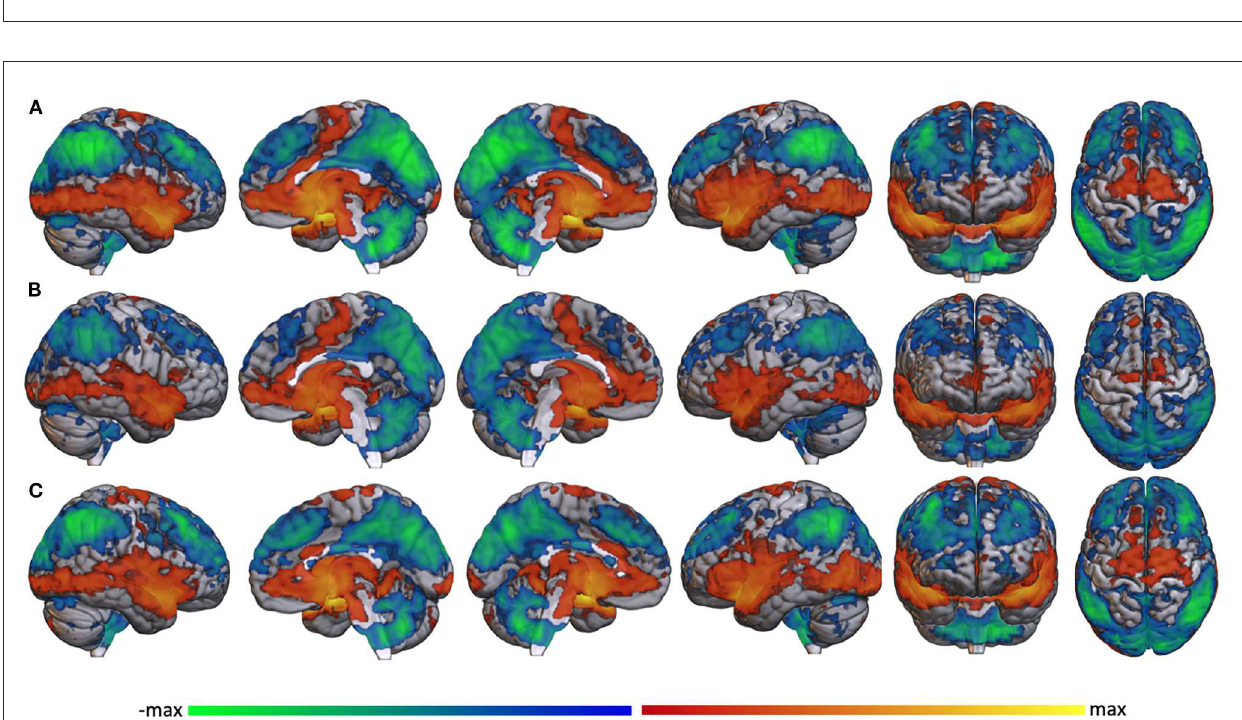
FIGURE1 Left and right amygdala volume. Left (pink) and right (yellow) amygdala volumes in the mTBI and TBI- groups, separated by high (PCL-5 > 33; PTS + ) and low (PCL-5 ≤ 33; PTS-) PTS symptom severity scores. Volumes are displayed as percent of total intracranial volume. No significant differences were found in left or right amygdala volume either within or between groups.